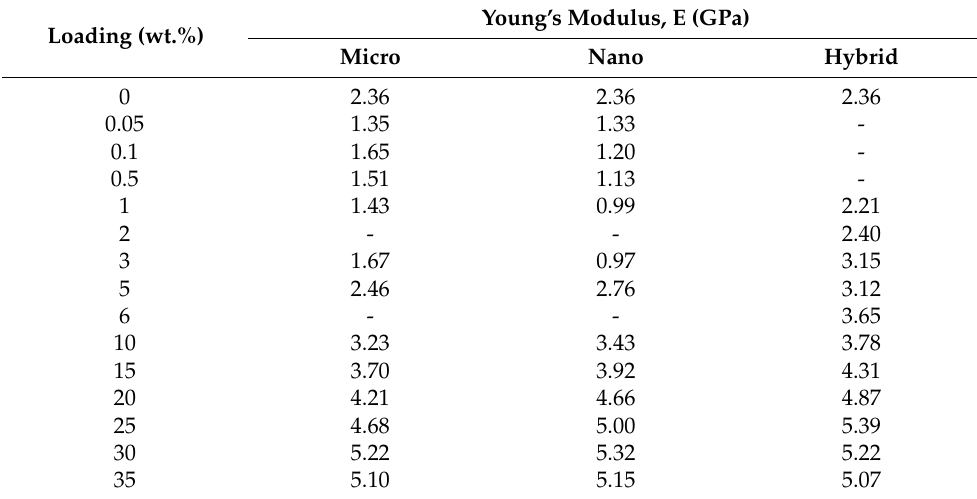
Table 2. Young’s modulus test result for micro, nano, and hybrid silica fillers. Loading